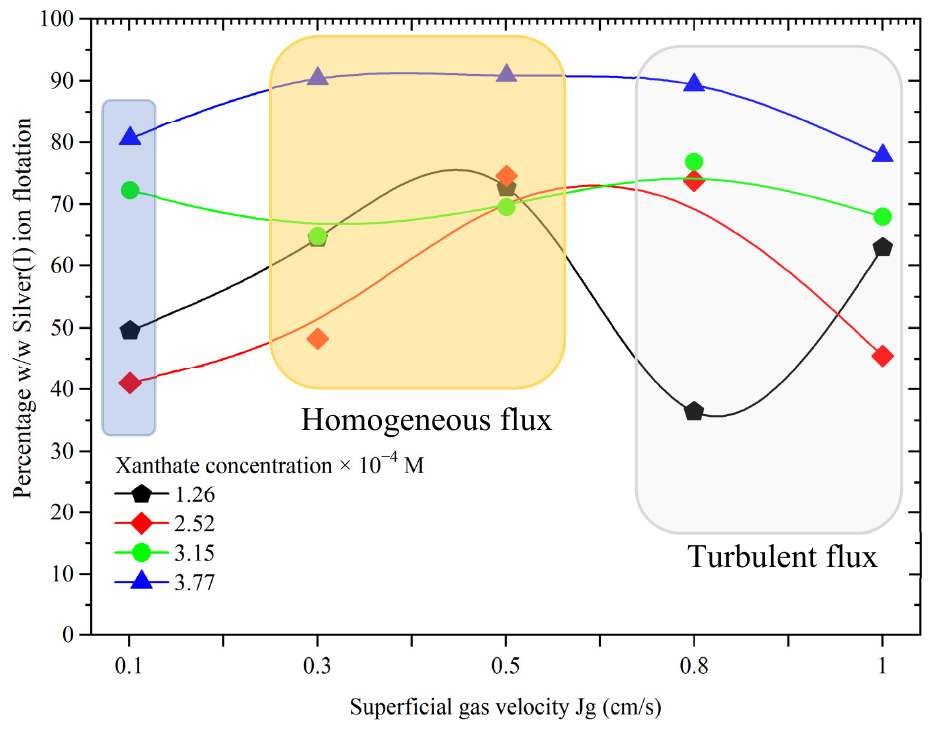
Figure 8. Percentage of w / w of silver(I) ion flotation as function of superficial gas velocity, ceramic sparger, Jl 0.19 cm/s, and [e] 1.26, 2.52, 3.15 y 3.77 × 10 − 4 M of